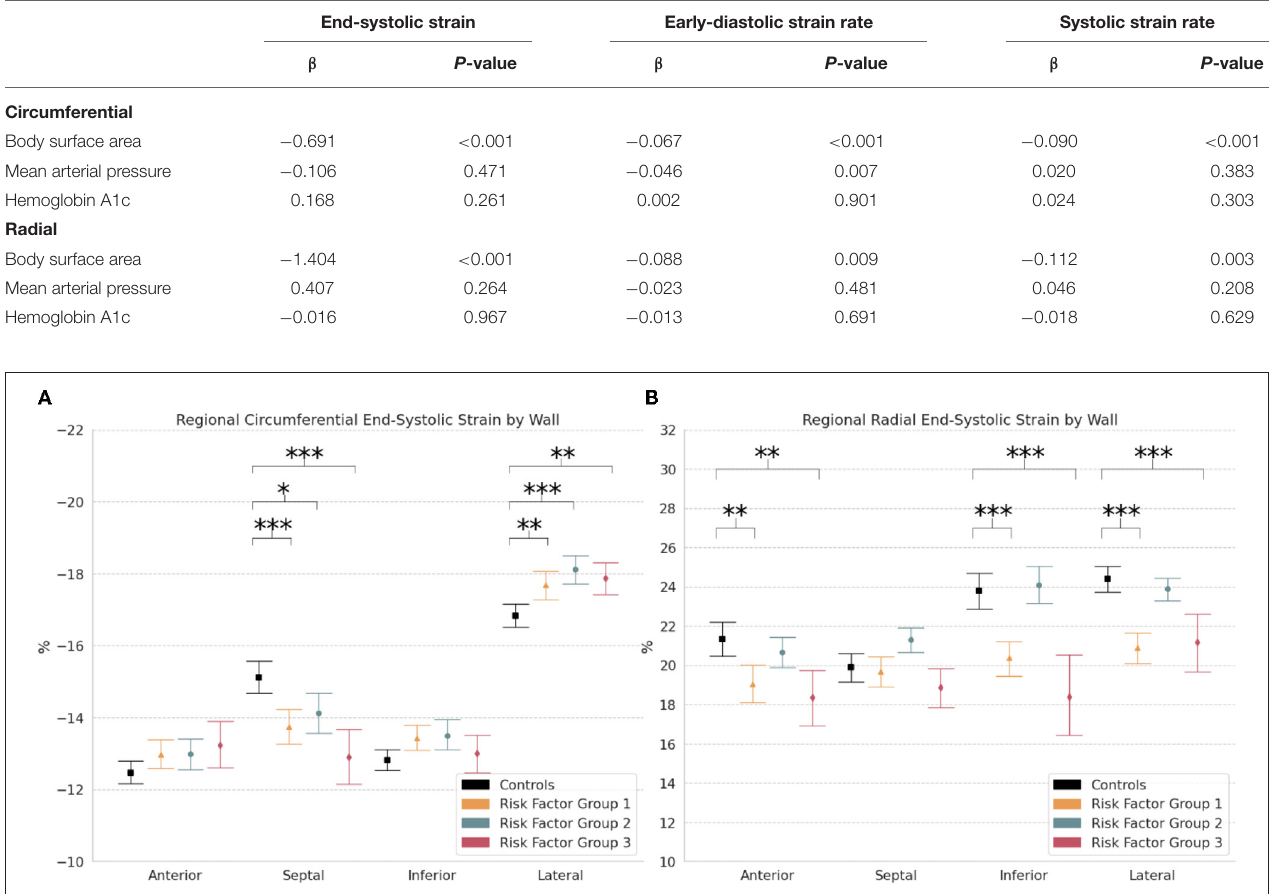
FIGURE 5 | Regional strain. Measures of (A) Circumferential and (B) Radial end-systolic strain by wall (i.e., anterior, septal, inferior, and lateral) in controls and risk factor groups. Strain results are visualized as mean with 95% confidence interval. post-hoc test by Bonferroni: * p < 0.05; ** p < 0.01; *** p <